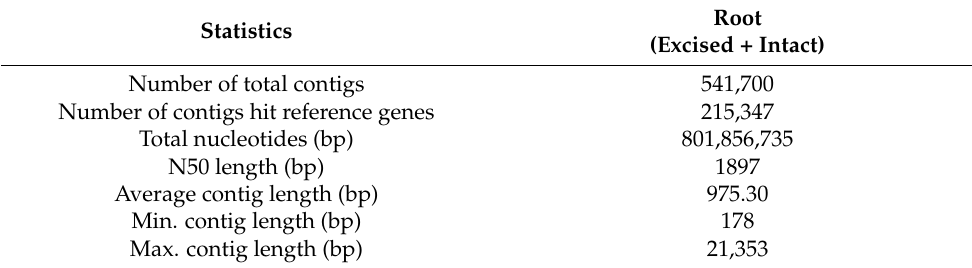
Table 1. De novo transcriptome assembly